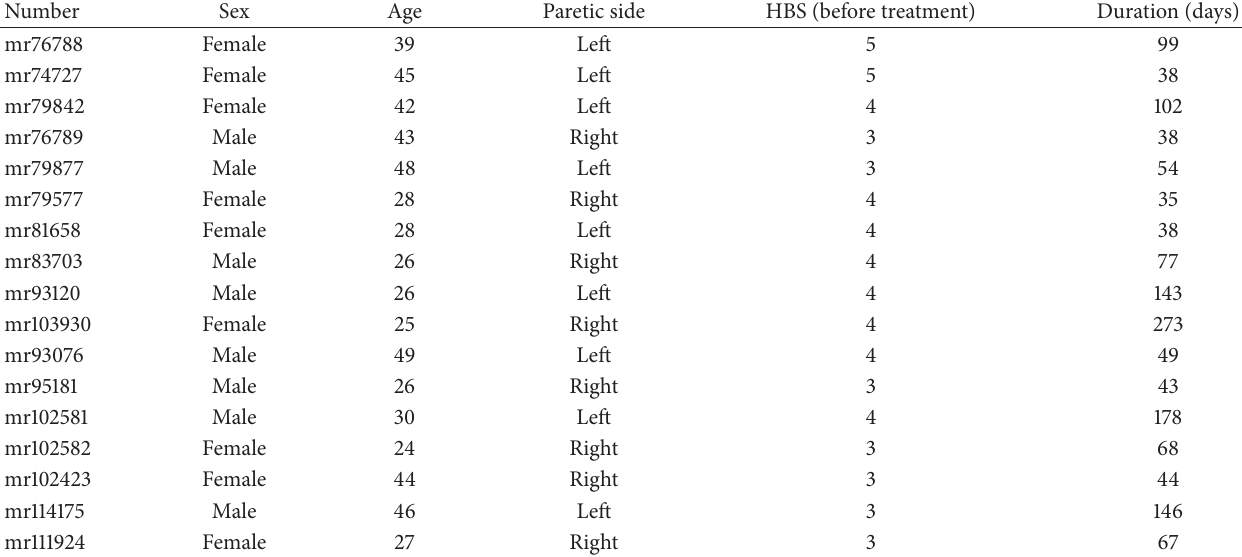
Table 1: Information of patients recovered from